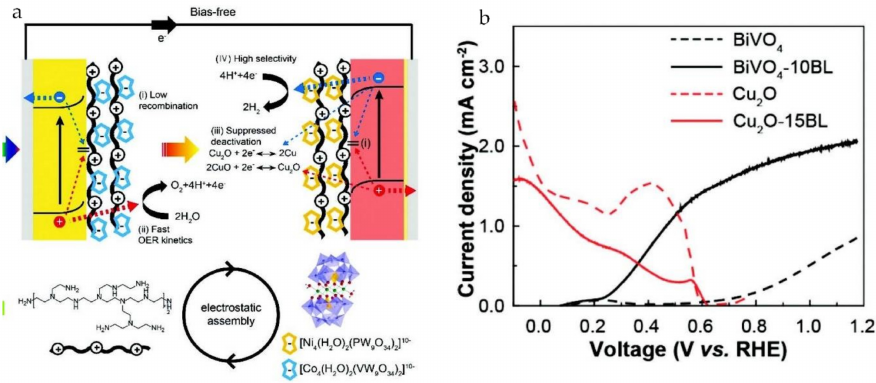
Figure 11. ( a ) Schematic illustrations explaining the inherent problems of a PEC cell composed of a Cu 2 O photocathode and BiVO 4 photoanode. ( b ) LSV curves of the Cu 2 O photocathodes and BiVO 4 photoanodes measured with and without the respective catalytic multilayers.